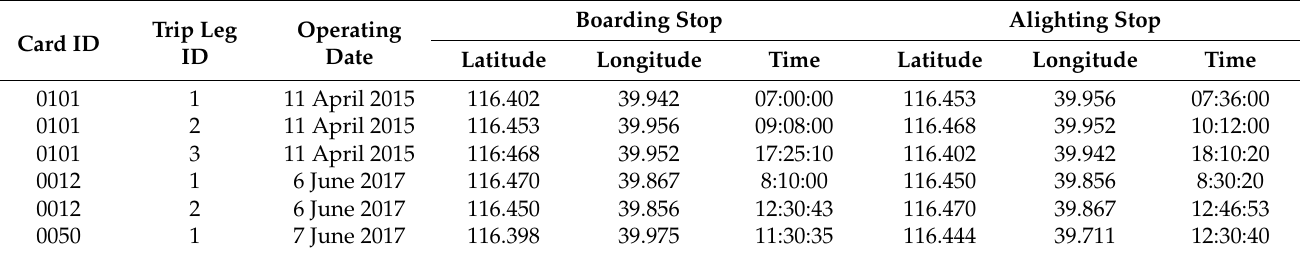
Table 2. Examples of smart card data